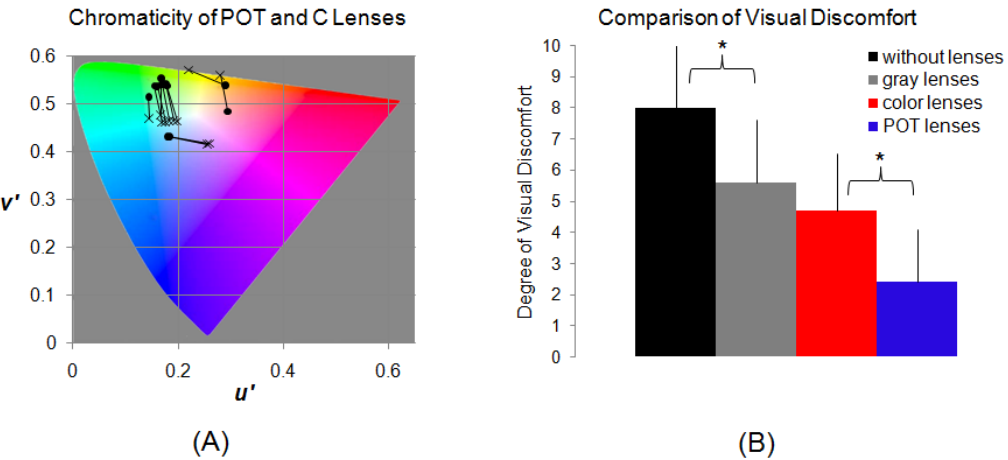
Figure 1. ( A ): CIE 1976 UCS diagram showing the chromaticities of the POTs and the control C lenses used by the eleven migraine patients and their control participants in the fMRI study. The chromaticity of each POT is marked by a solid circular point, and a line connects the point to the chromaticity of its paired control C lens (cross). ( B ): The effects of the POT, the control C, and gray (G) lenses in reducing visual discomfort in the migraine patients relative to those without lenses when viewing the stressful pattern out of doors in direct sunlight. The degree of visual discomfort was self-scored using a 0 to 10 scale, with 0 representing no visual discomfort and 10 representing severe visual discomfort. Reproduced with permission from [14]. (For further details, refer to [14]). The reduction with the POT lenses was significantly larger than that with the coloured lenses ( t -test, p = 0.005), marked with *.